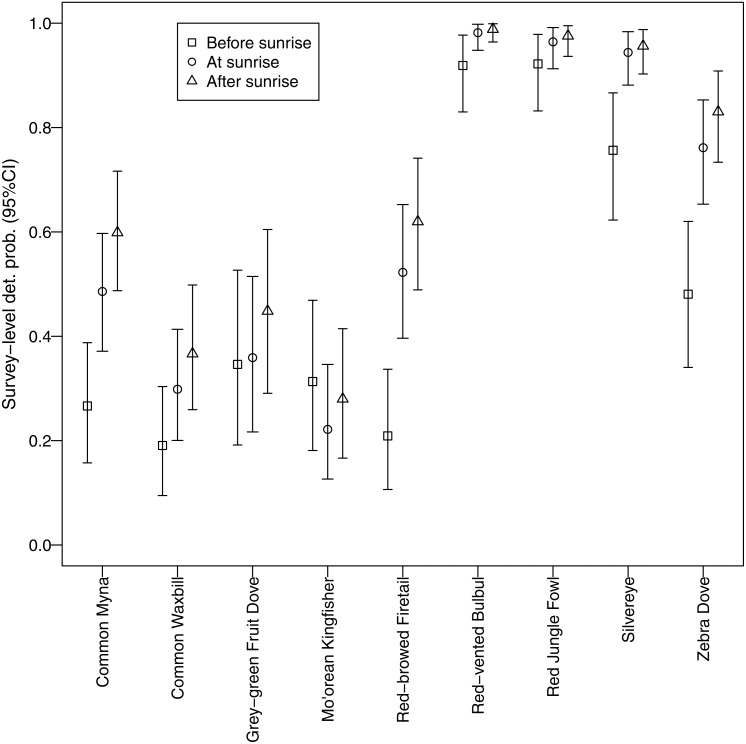
Canopy cover detection probability.Associations between forest canopy cover and detection probability for avian species surveyed using automated recorders. We deemed there to be an association when the credible interval for the parameter estimate did not overlap zero.